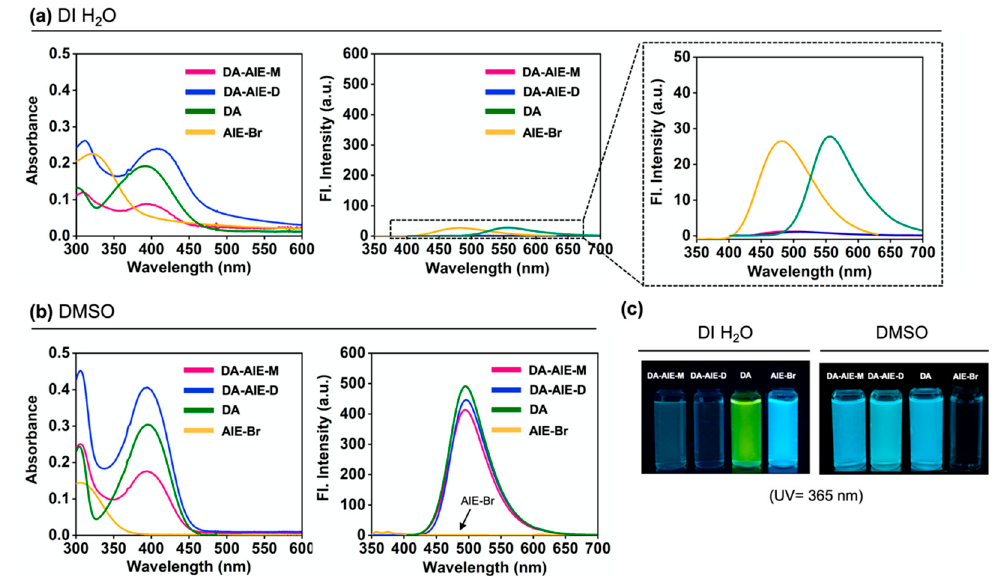
Figure 4. Absorption and emission spectra of DA-AIE-M (10 μ M), DA-AIE-D (10 μ M), DA (10 μ M), and AIE-Br (10 μ M) in ( a ) DI H 2 O, ( b ) DMSO at 25 °C. The emission spectra were produced in each solvent under excitation at the maximum absorption wavelength. ( c ) Photos: each compound (10 μ M) is dissolved in DI H 2 O and DMSO under UV light (365